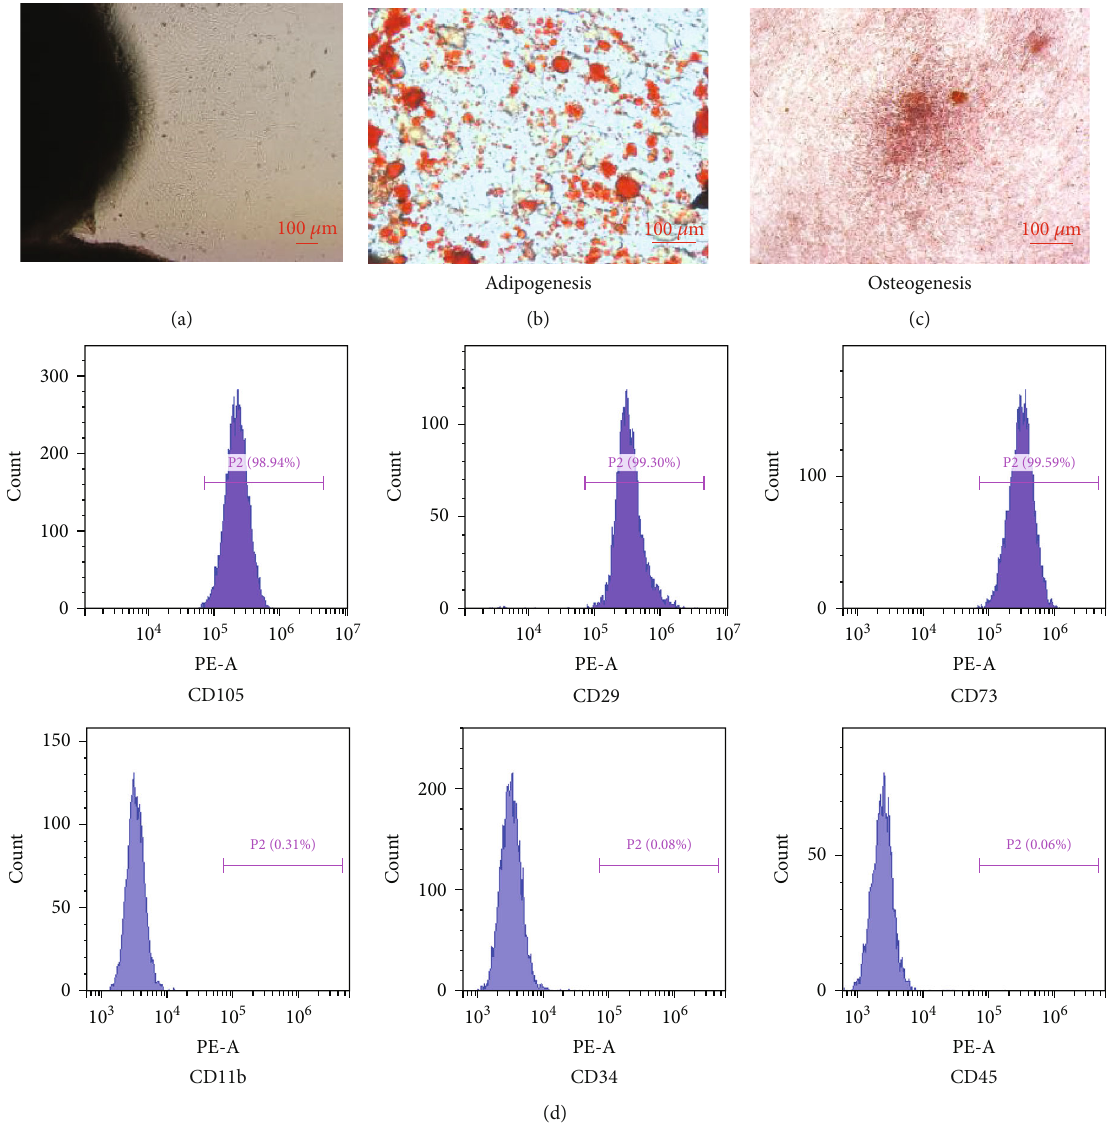
Figure 1: Identi fi cation and di ff erentiation potential of huc-MSCs. (a) MSCs with their characteristic fusiform shape were grown on the 10th day of culture ( × 40). (b) Oil Red O staining for the adipogenic di ff erentiation of huc-MSCs ( × 100). (c) Alizarin Red staining for the osteogenic di ff erentiation of huc-MSCs ( × 100). (d) Flow cytometry for the surface antigens of huc-MSCs. The huc-MSCs expressed CD105, CD29, and CD73 but lacked expression of CD11b, CD34, and